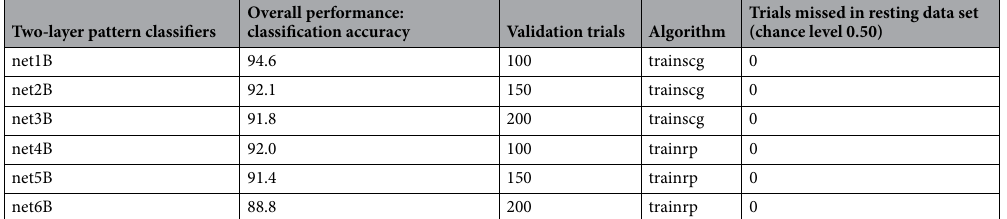
Table 3. Overall performance accuracy, validation trials, algorithms and trials which could not be categorized in the resting dataset for different two-layer feedforward networks. The networks were composed of 121 neurons in the first layer and 41 in the second layer. Net1B has finally been selected.